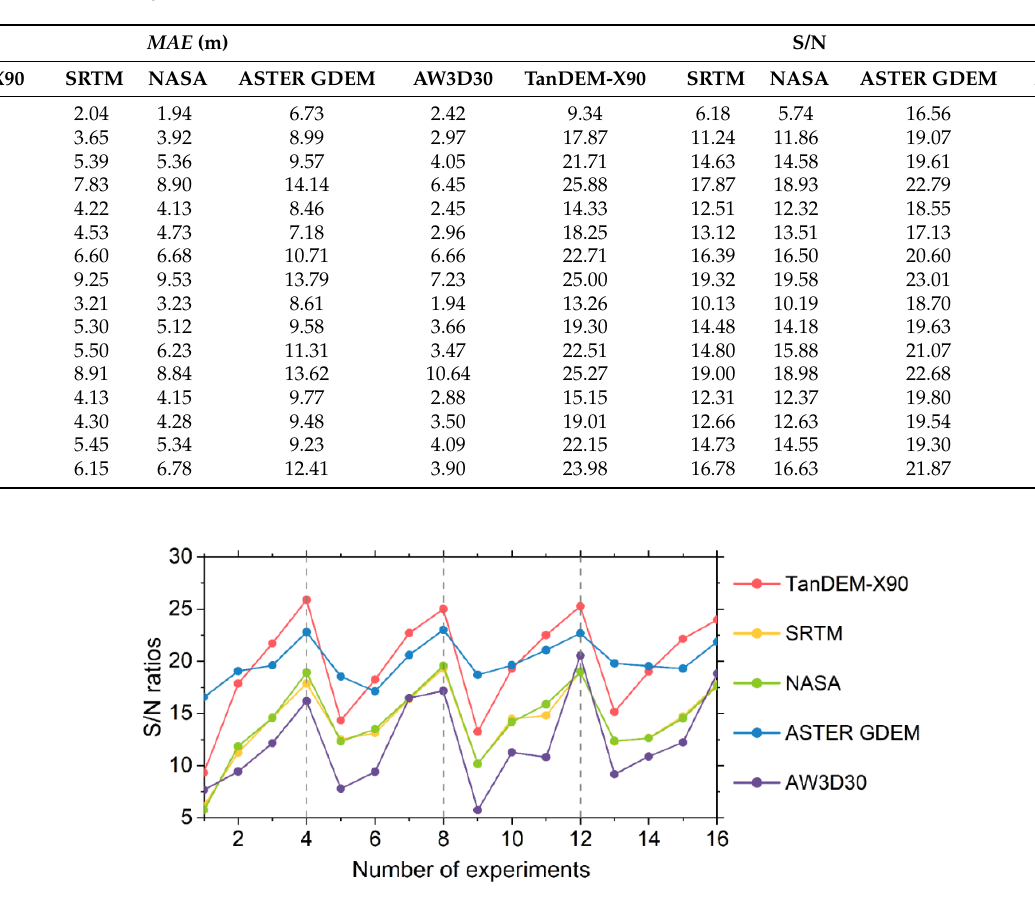
9.0 Figure 16. Percentage of contribution of each factor to MAE in the study area.